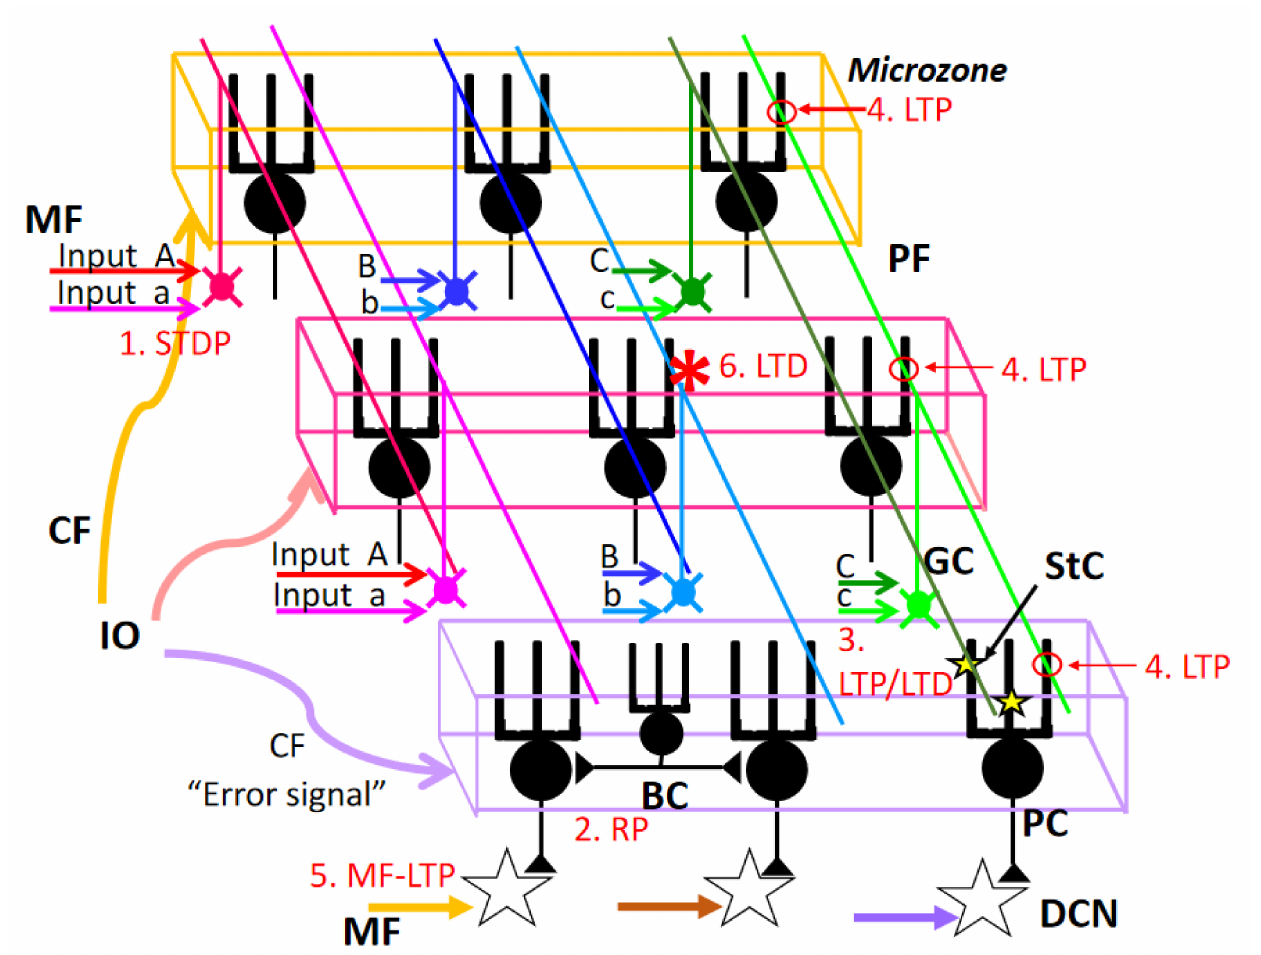
Figure 3. Multiple forms of synaptic plasticity with a special concern of spatial range. (1) STDP: spike timing-dependent plasticity MF–GrC synapse. (2) RP: rebound potentiation at inhibitory interneuron–PC synapse. RP should be induced in PCs innervated by the same CF (microzone). (3) LTP/LTD: Long-term potentiation or long-term depression at StC–PC synapses. This type of plasticity should be part of PC dendrites. (4) LTP: LTP at GrC–PC synapse. The postsynaptic type of LTP should be induced at PF–PC synapse along the same PF, except if conjunctively activated by CF. (5) MF-LTP: LTP